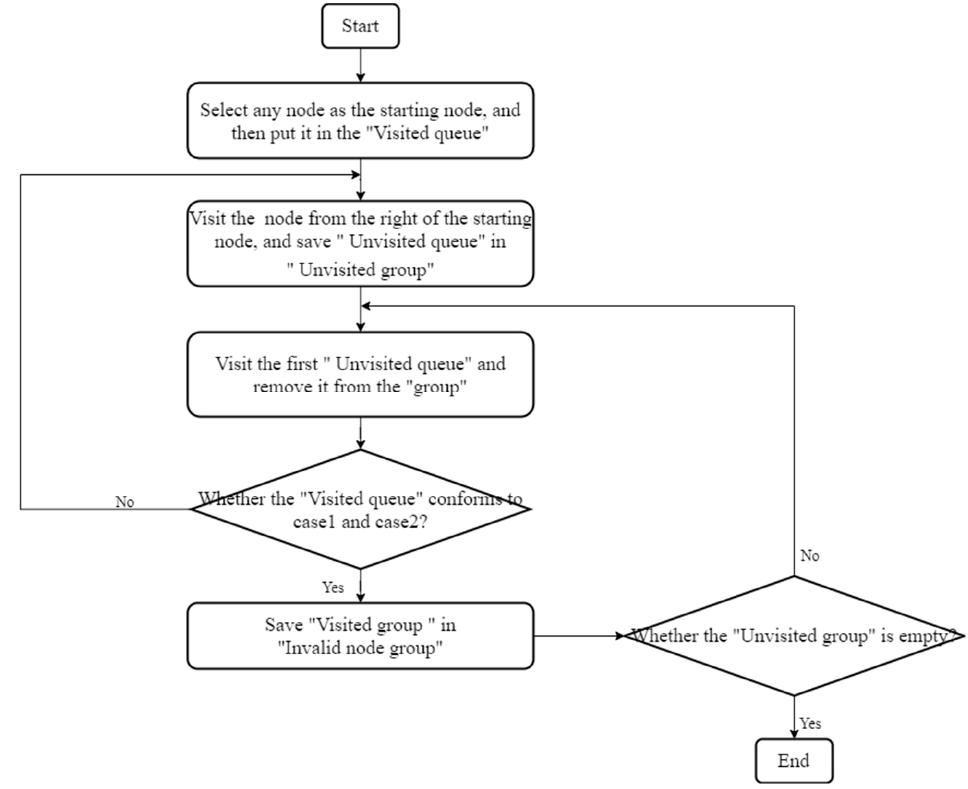
Figure 15. Flowchart of the improved DFS algorithm.